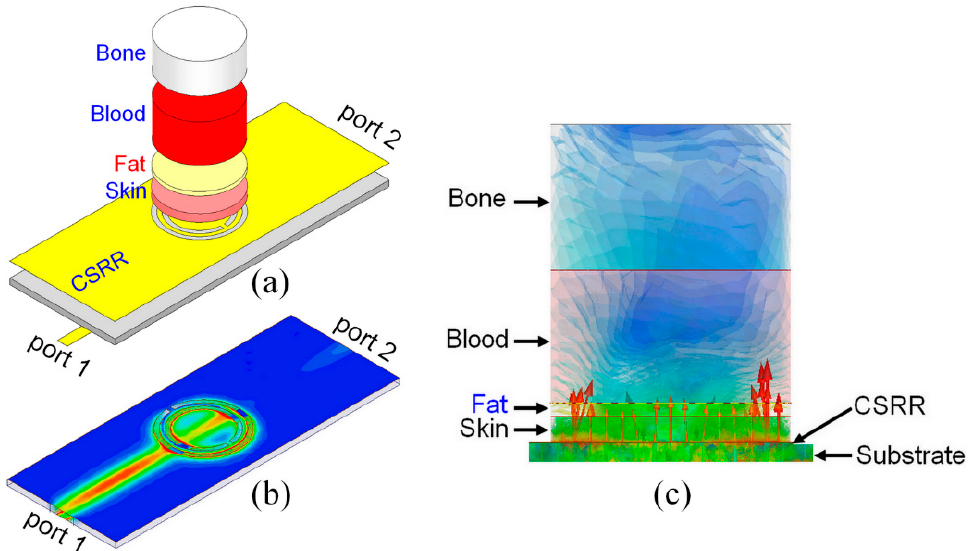
Figure 5. The analyzed four-layers Cole–Cole finger model along with the CSRR sensor using HFSS in ( a ) the electric field distribution on the CSRR at the resonance frequency of 2.3 GHz in ( b ) the distribution of electric vector fields and intensity across the four-layers fingertip model in ( c ).